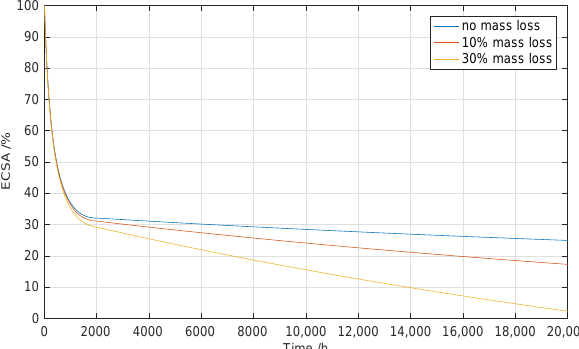
Figure 5. Contribution of catalyst mass loss to ECSA